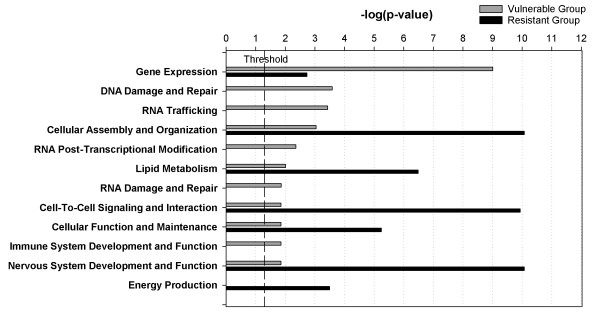
Comparison of transcriptomic profiles between the VUL and RES neurons based on biological functions associated with the differentially expressed genes identified in each neuronal group. The threshold line corresponds to the -log value for P = 0.05. Values of significance that is higher than threshold indicate greater numbers of genes, from either VUL or RES neurons, associated with the corresponding biological function. For example, although expression of genes related to the biological function of "Gene Expression" reached a value of significance above-threshold for both VUL and RES neurons, there were many more genes expressed in VUL neurons (54 in total) than the RES neurons (2), thus a higher -log P value for VUL than RES.